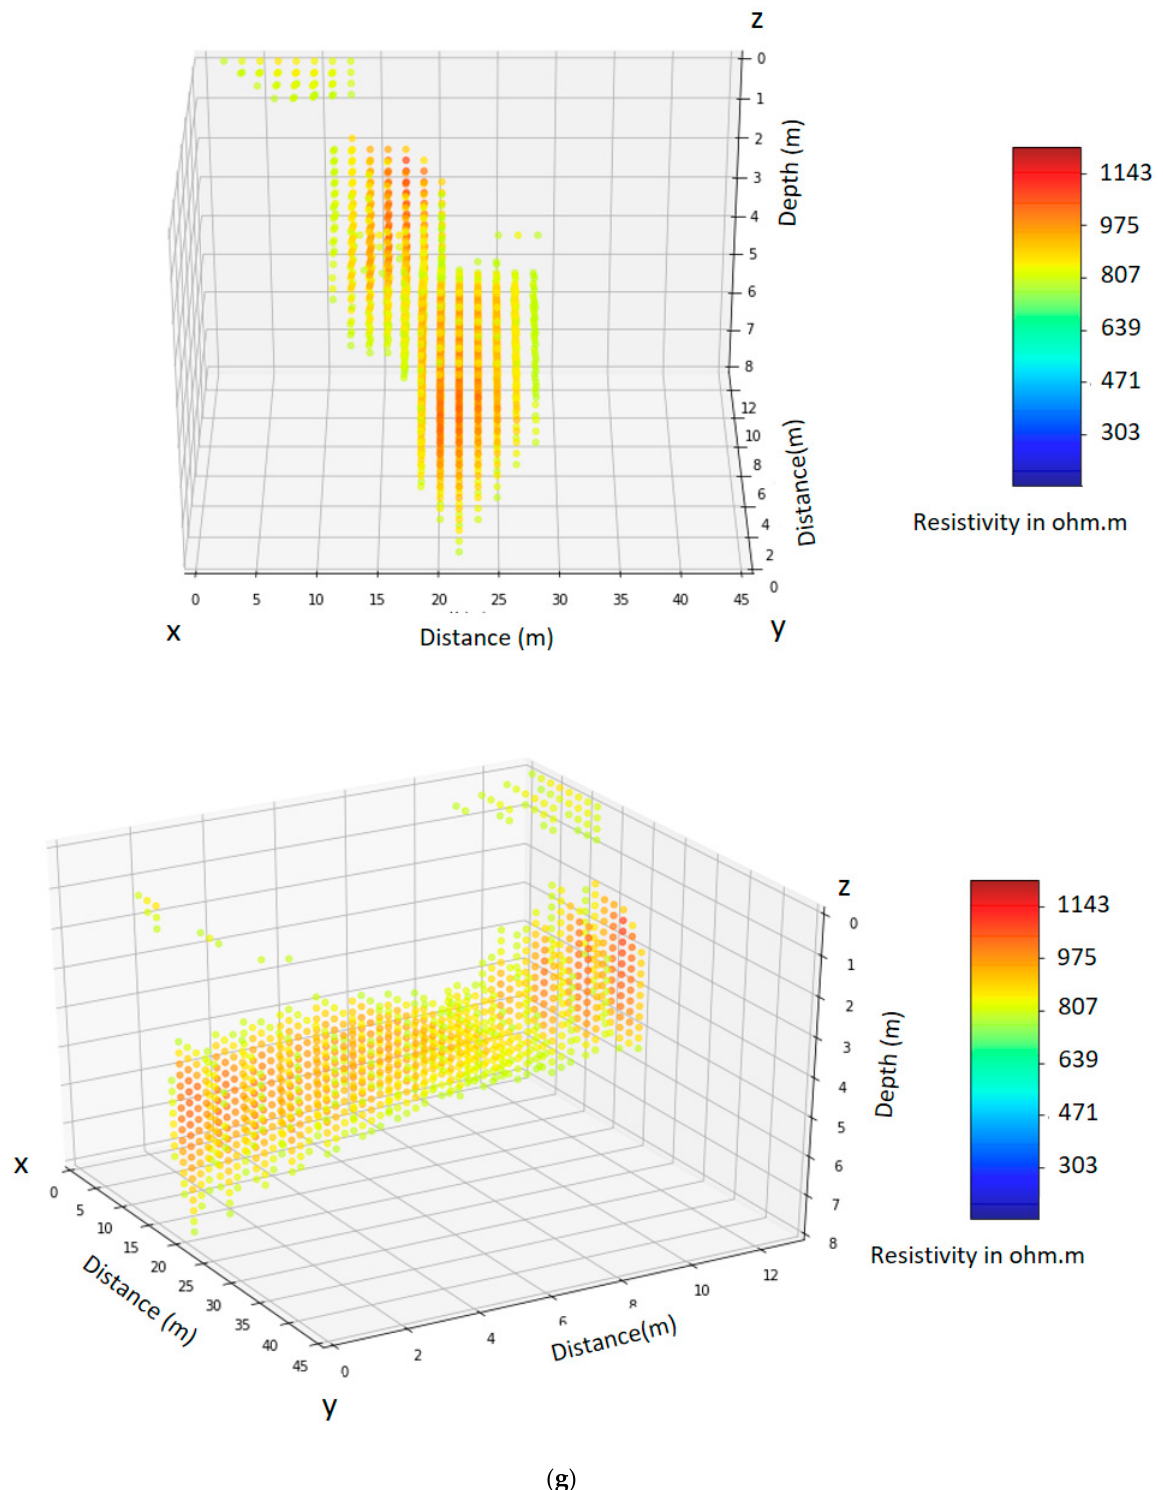
Figure 9. Deep learning prediction results ( a – g ). ( a ) Original data of L1, L2, and L3; ( b ) Error rate of MLP network training process; ( c ) Result of the original data of L1, L2, and L3 after MLP data prediction; ( d ) Result of unknown regions of L1, L2, and L3 after MLP data prediction; ( e ) Result of successive profiles after MLP data prediction; ( f ) Result of 3D resistivity model; ( g ) MLP predicted tunnel location and path.